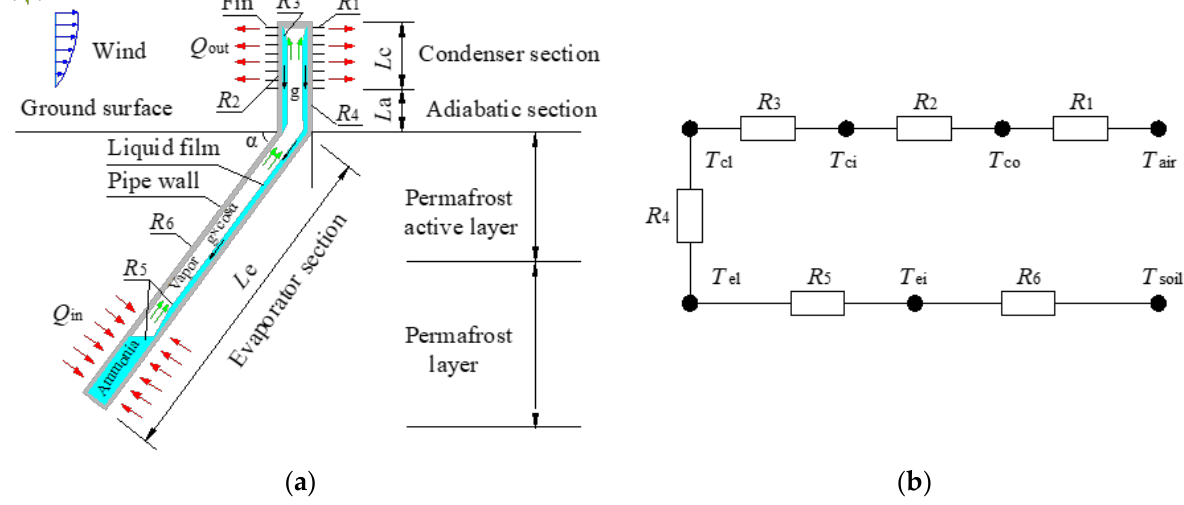
Figure 1. ( a ) Working mechanism diagram and ( b ) thermal resistance network of an L-shaped TPCT.